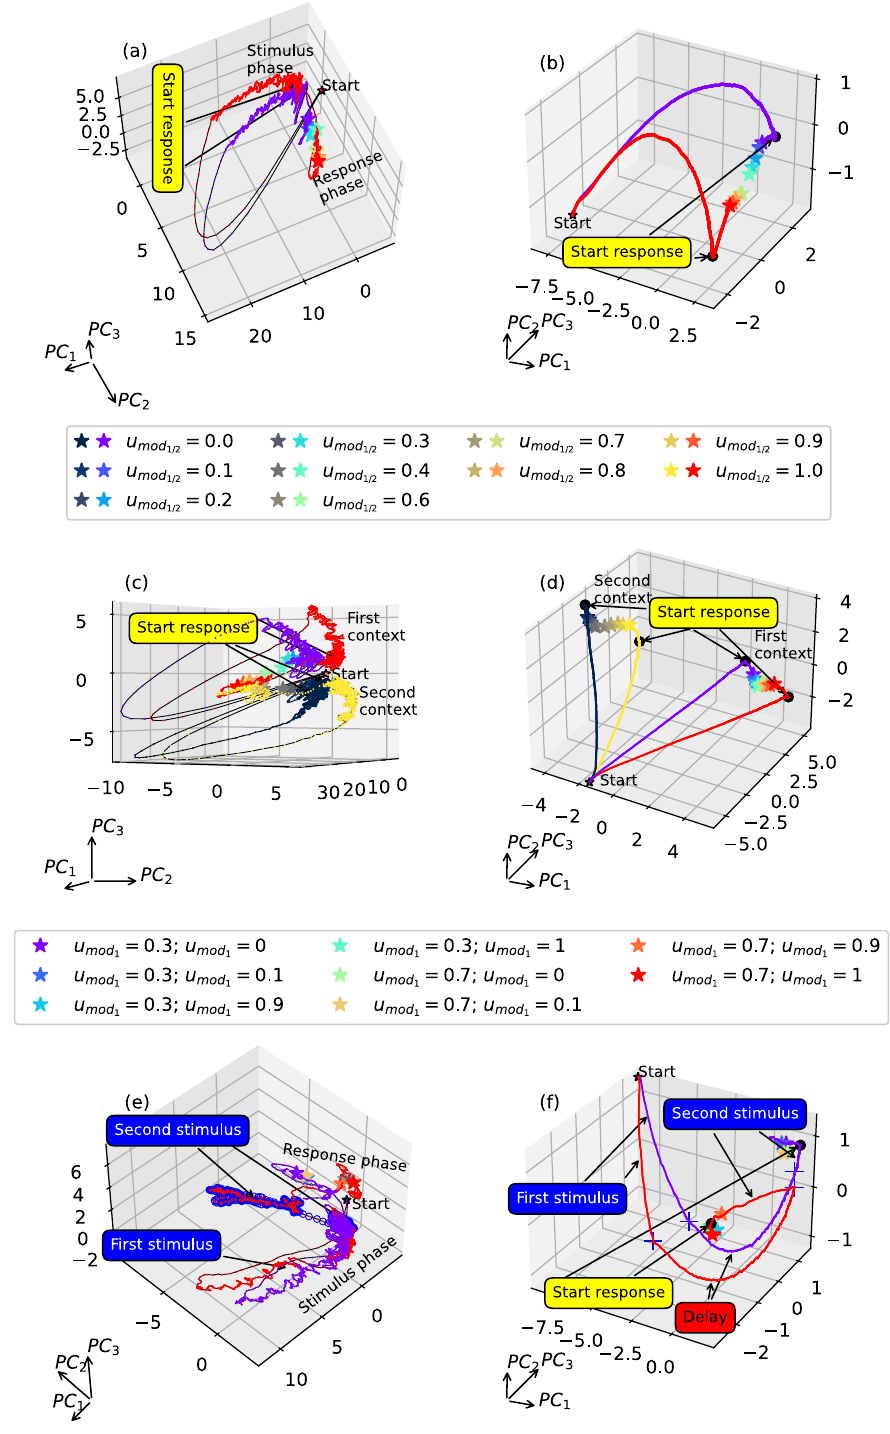
Figure 9. Projections of the neural activity trajectories onto the subspace of the first three principal components for variables v j (left column) and a j (right column) for the network with 256 neurons and the regularized loss function when performing the DM ( a , b ), CtxDM ( c , d ), and Romo ( e , f ) tasks. The black star indicates the beginning of each trial, and the colored stars show the termination points. The black point indicates the beginning of the response phase. Pulse symbols indicate the delay periods ( f ). Trajectories are only shown for the minimum and maximum input values for clarity. The colored asterisks in the left column show the 100th iteration of the corresponding response phase, and those in the right column show the last iteration of the response phase. The results of the network with 256 neurons trained with the regularized loss function are